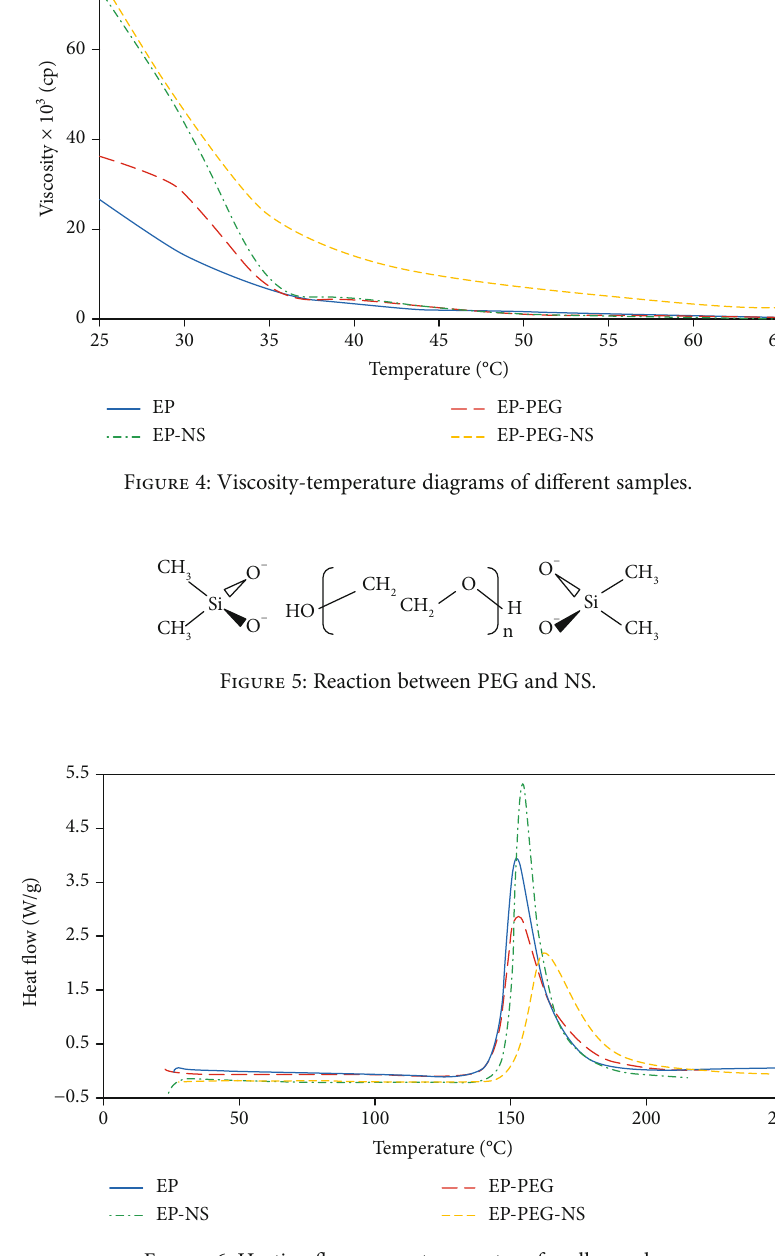
Figure 6: Heating fl ow versus temperature for all samples.